Question: Write a single sentence explaining what this figure depicts.
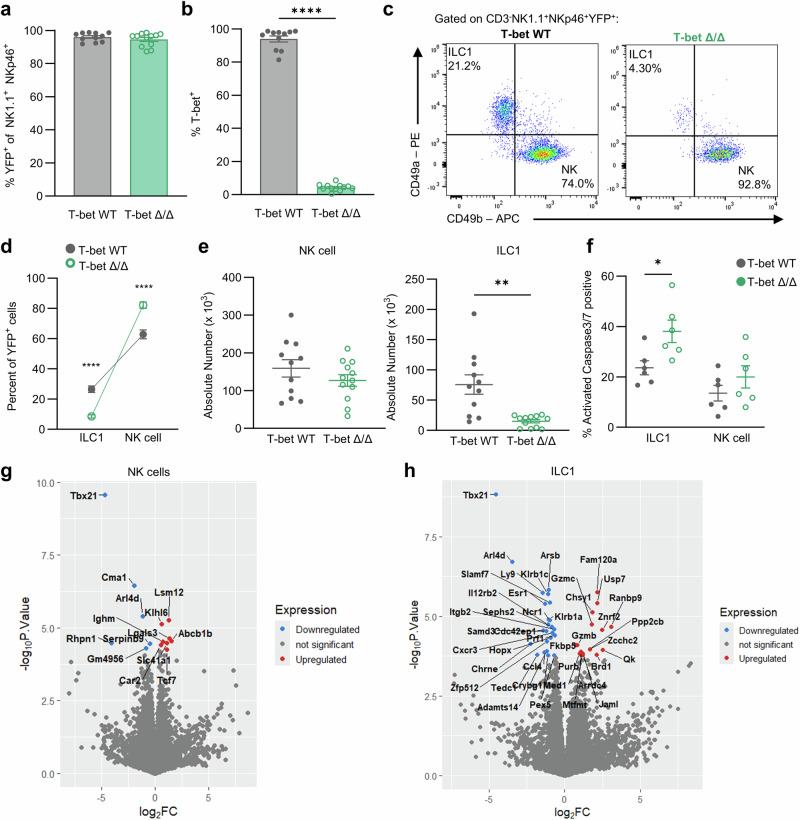
Answer: Liver ILC1s require sustained expression of T-bet to persist. Ncr1 -iCreER T2 x Rosa26- YFP LSL x Tbx21 fl/fl (T-bet Δ/Δ) and Ncr1-iCreER T2 x Rosa26-YFP LSL x Tbx21 WT/WT (T-bet WT) mice were treated with 1 mg tamoxifen by oral gavage for 3 days (Day 1-3), then on Day 6, livers were harvested for analysis. a YFP + percentage within all NK1.1 + NKp46 + cells in the liver ( n = 11-12 per group). b Percentage of T-bet + cells within YFP + NK1.1 + NKp46 + cells in the liver ( n = 11-12 per group). c Representative flow plots and d , summary percentages of YFP + ILC1s (CD49a + CD49b - ) and NK cells (CD49a - CD49b + ) ( n = 11-12 per group). e Absolute numbers of YFP + NK cells and YFP + ILC1s in the liver ( n = 11-12 per group). f Apoptosis assessed by activated Caspase 3/7. 2-3 independent experiments ( n = 6 per group). Summary data are shown as mean ± SEM; Statistical significance was determined by unpaired two-sided t-test with Welch’s correction in a, b and e and determined by 2-way ANOVA with Šídák’s multiple comparisons test in c and f for adjusted p values. * = p < 0.05, ** = p < 0.01, *** = p < 0.001, **** = p < 0.0001. Exact p-values are provided in the Source Data file. g, h T-bet Δ/Δ mice were treated with 1 mg tamoxifen by oral gavage for 2 days (Day 1-3), then on Day 3, liver g, NK cells and h, ILC1 from the same mice were flow sorted and used for RNA-sequencing. Genes with adjusted p-values ≤ 0.05 were colored to be upregulated (red) or downregulated (blue). n = 4 mice per group.